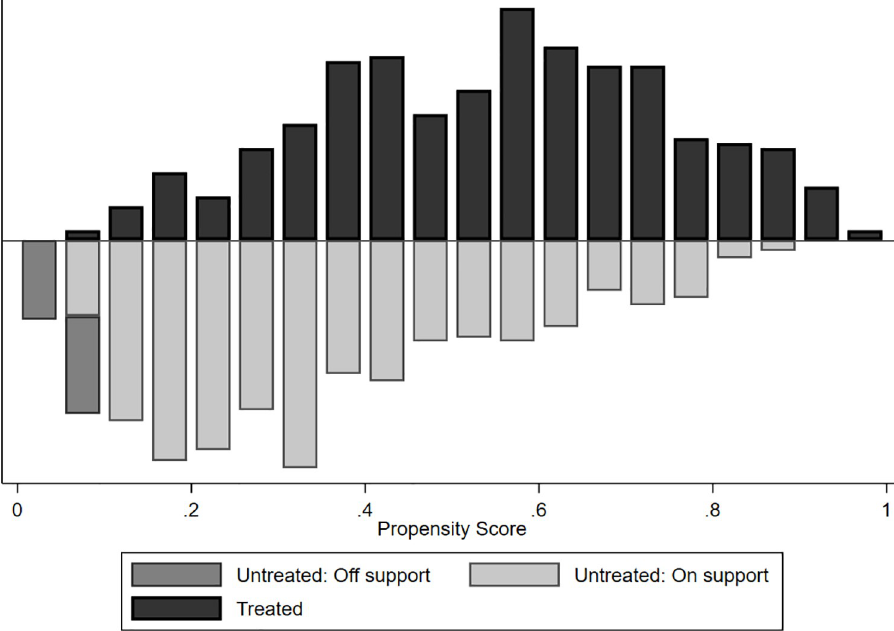
Fig 1. Distribution of estimated propensity scores and region of common